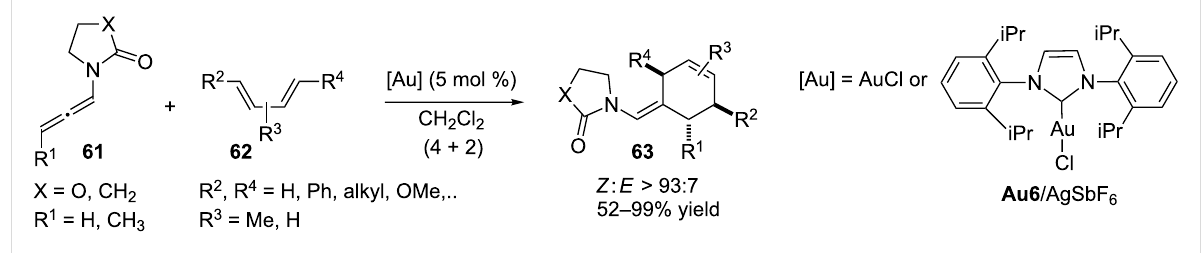
Scheme 32: Gold(I)-catalyzed intermolecular (4 + 2) cycloaddition of allenamides and acyclic dienes [109].